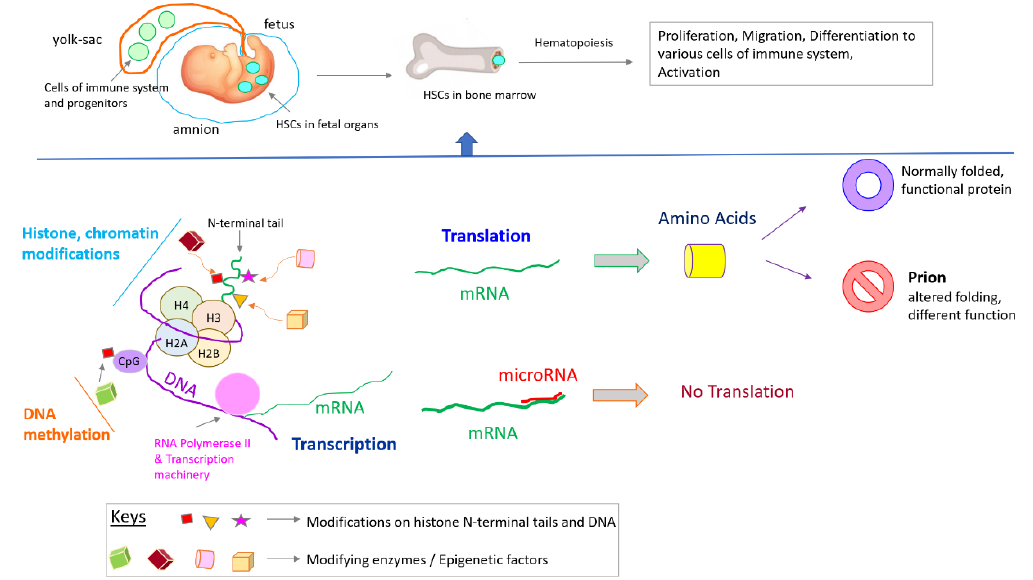
Figure 1. Epigenetic regulations of immune system development and activation. Abbreviations: HSCs—hematopoietic stem cells. H2A, H2B, H3, H4—core histones.